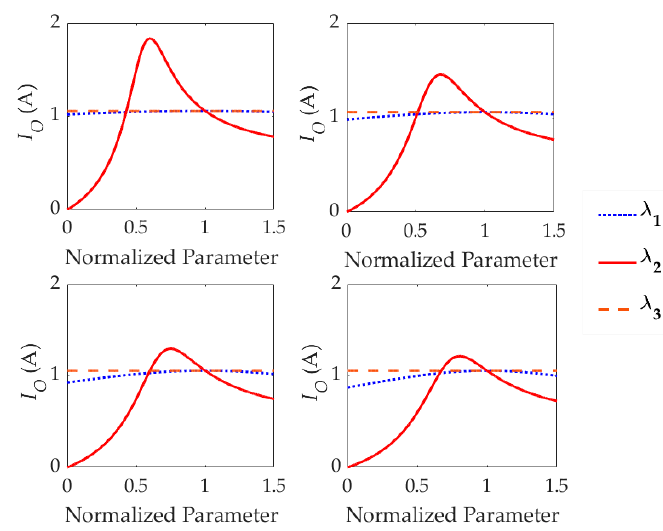
Figure 5. I O versus normalized parameters.